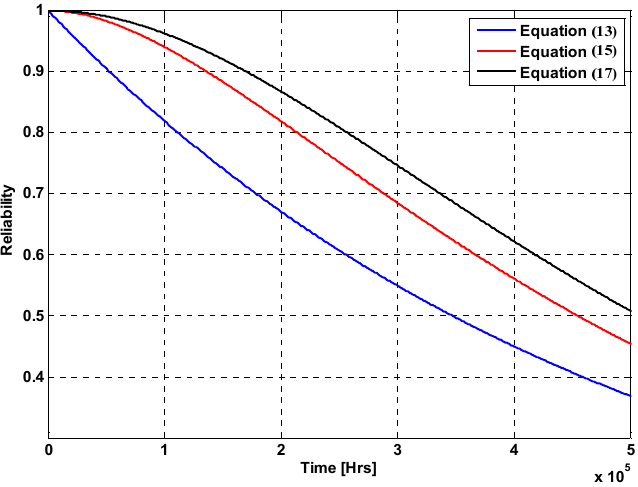
Figure 5. Reliability calculation results.